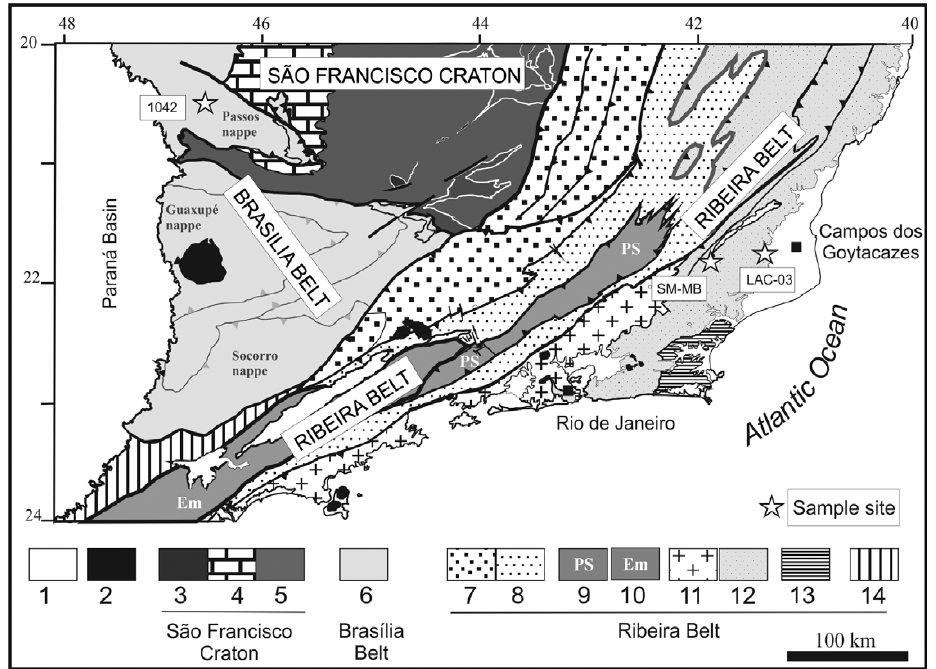
Figure 3 - Tectonic features of SE Brazil and location of studied samples (modified from Heilbron et al. 2008). Legend: 1- Phanerozoic cover; 2- Mesozoic-Paleogene alkaline intrusions. Units of